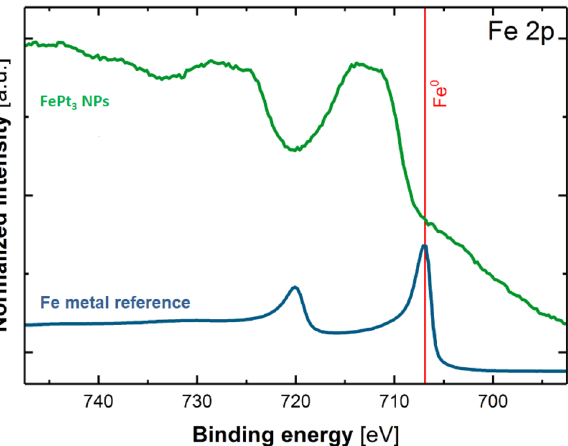
Fig. 6 Fe 2 p XPS spectrum of the FePt